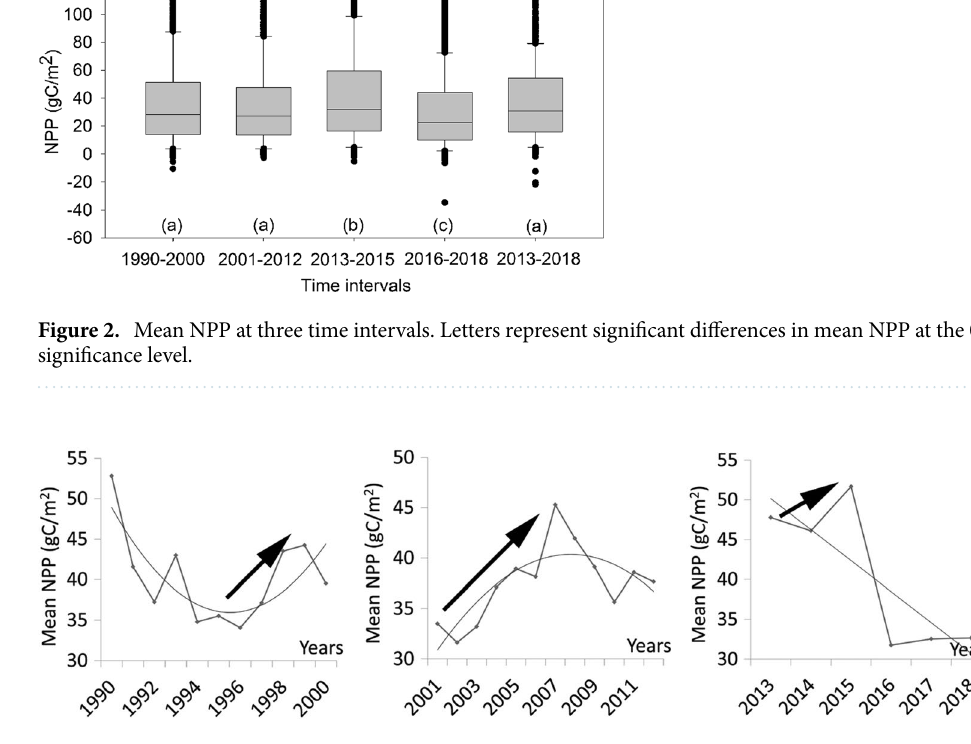
Figure 3. Trend of NPP in ( a ) 1990–2000, ( b ) 2001–2012, and ( c )